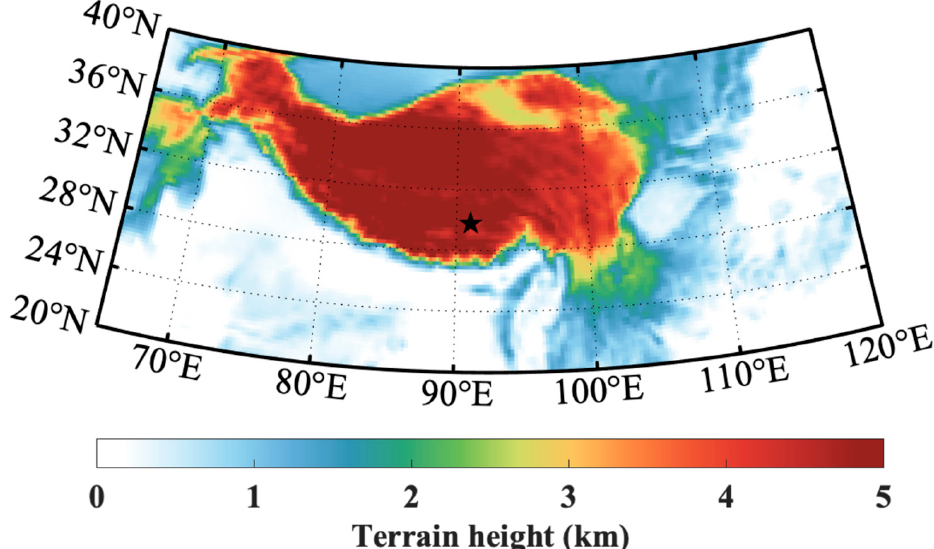
Figure 1. The elevation height of TP (color shaded) and the geographical location of Lhasa (penta- gram). This figure was plotted using the Lambert conformal conic projection.